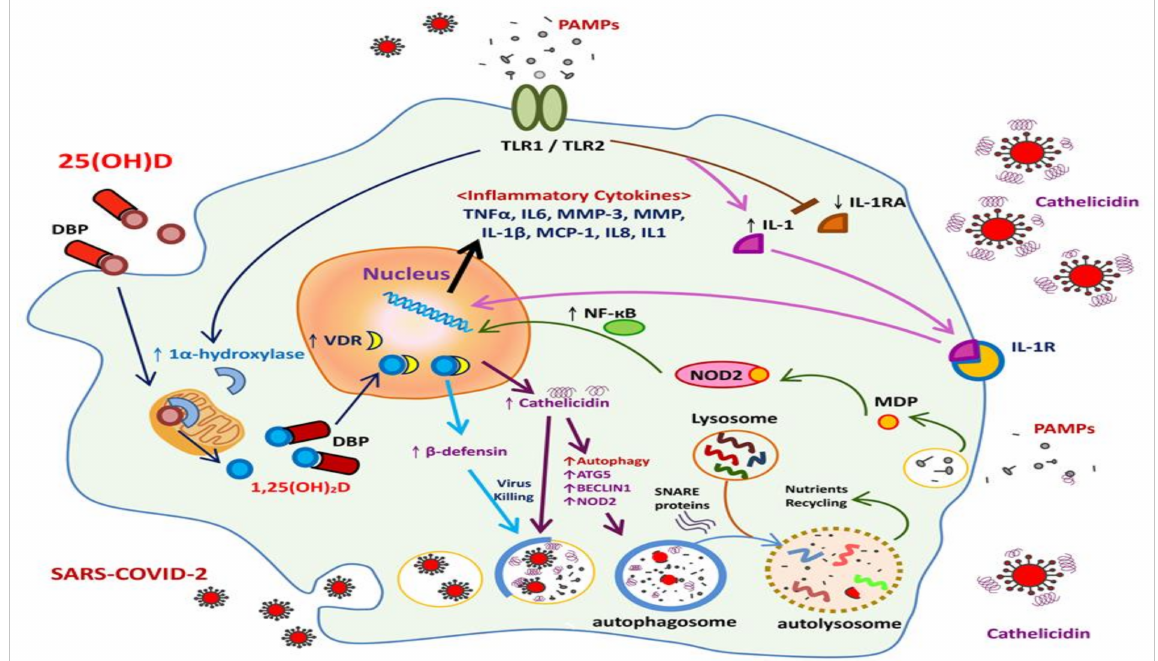
Figure 2. Putative vitamin D-related innate immunity (anti-infection activity) and autophagy responses to coronavirus disease 2019 (COVID-19) infection. The activation of monocyte toll-like receptors (TLR1/TLR2) by pathogen-associated molecular patterns (PAMPs) induces the expression of the cytokine interleukin-1 (IL-1) and suppresses the expression of the IL-1 receptor antagonist, thereby enhancing intracrine signaling by IL-1 and increasing the activity of nuclear factor к B